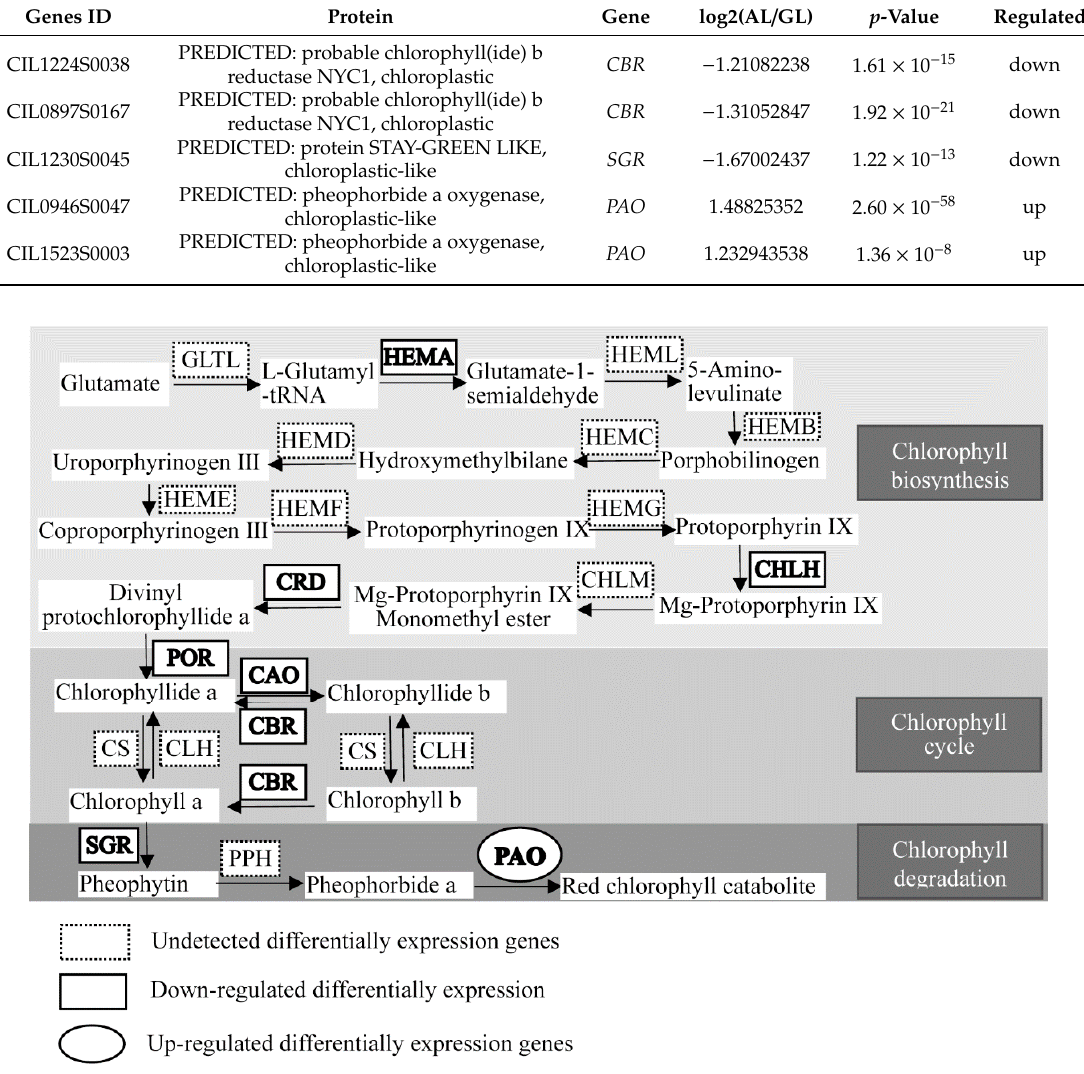
Figure 3. Chlorophyll metabolic pathway (KO00860) in albino leaves of pecan. CAO: